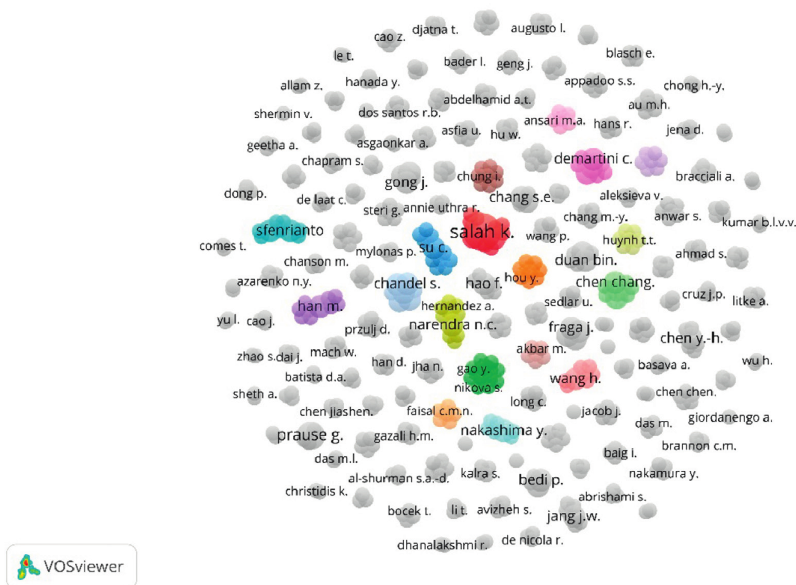
Figure 4: A collaborative network of authors.